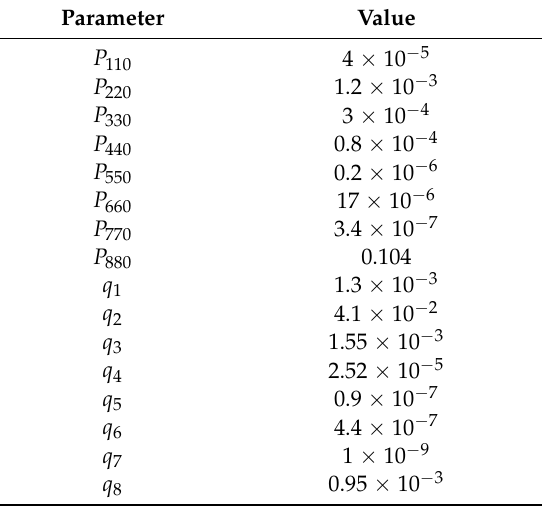
Table A3. Covariance